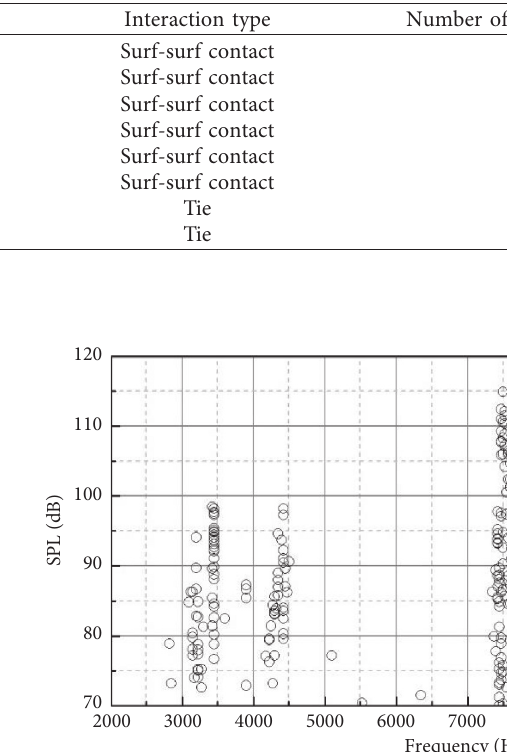
Table 2: Interactions in the brake system finite element model.